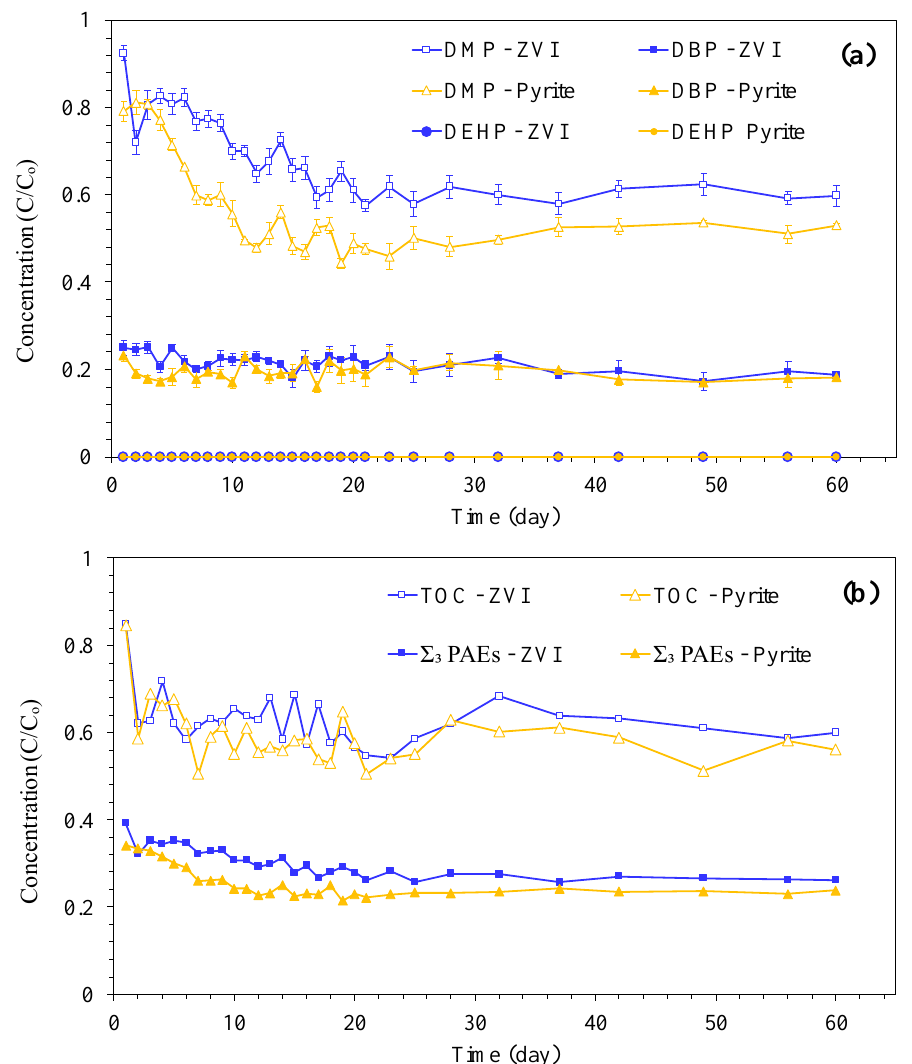
Figure 2. ( a ) Residual concentration of individual phthalic acid ester (PAE) in zero-valent iron (ZVI)–persulfate (PS) and pyrite–PS system, ( b ) comparison between residual Σ 3 PAEs and total organic carbon (TOC) concentration.